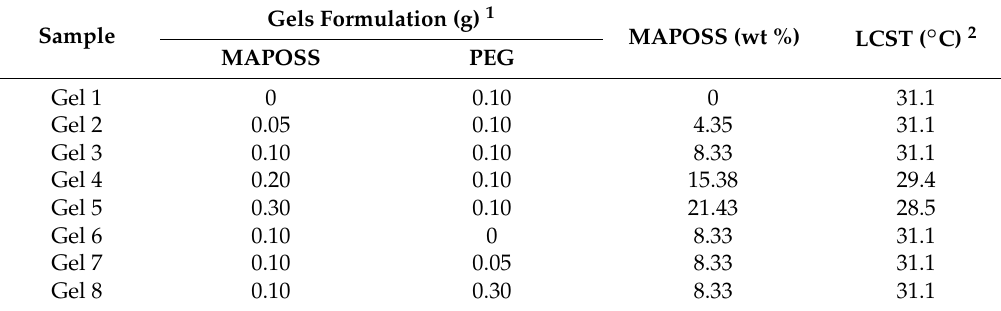
Table 1. PNIPAM-MAPOSS hybrid hydrogels composition and